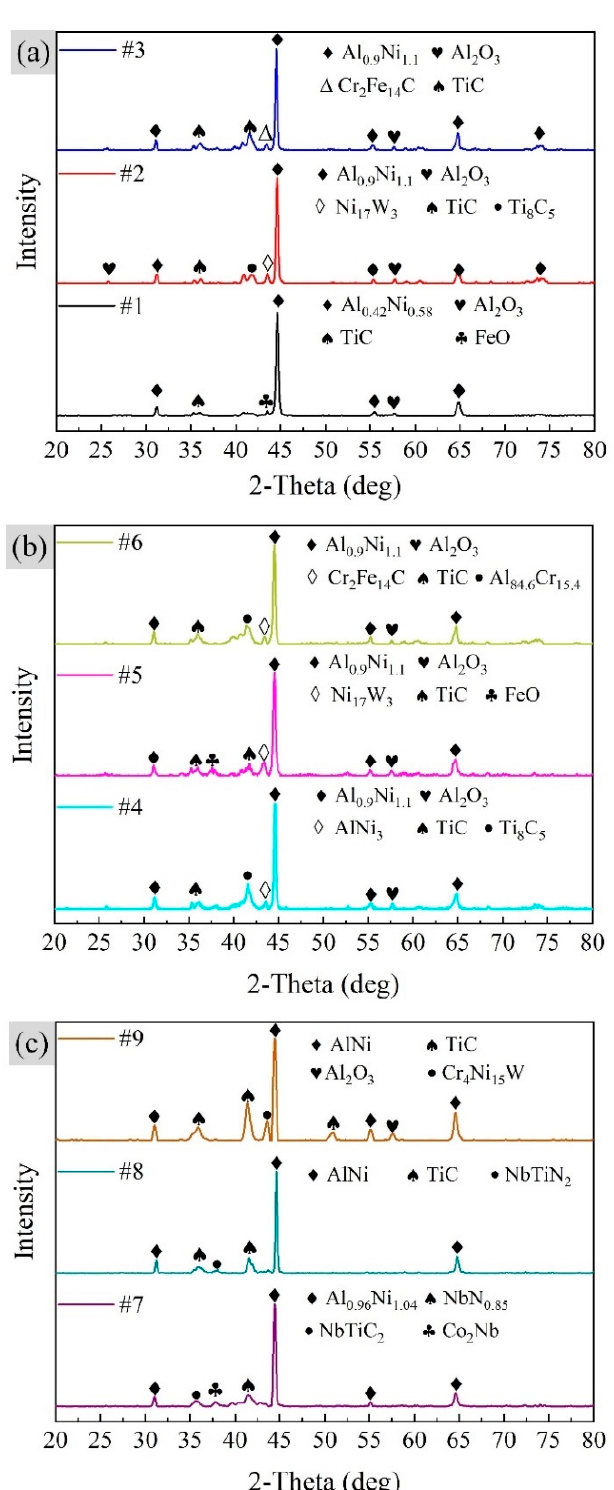
Figure 6. XRD patterns for aluminized specimens. ( a ) #1–3 specimens, ( b ) #4–6 specimens, and ( c ) #7–9 specimens.